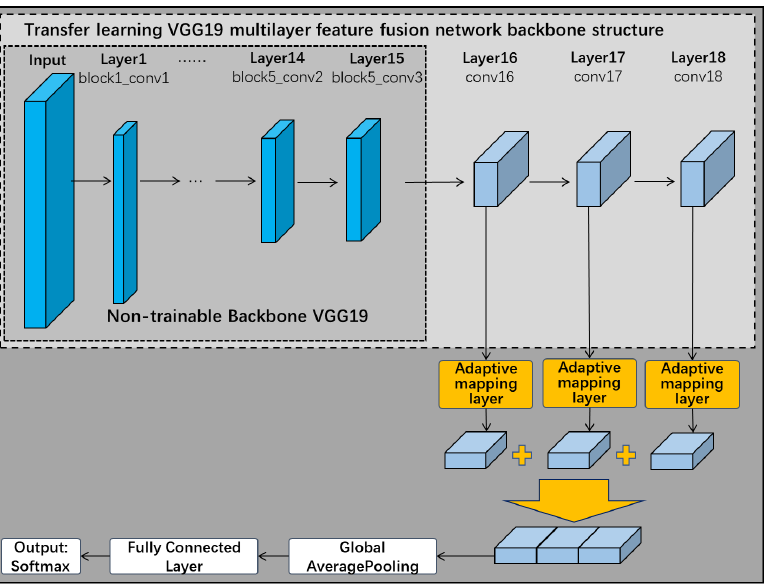
Figure 14. Improved transfer learning VGG19 multilayer feature fusion